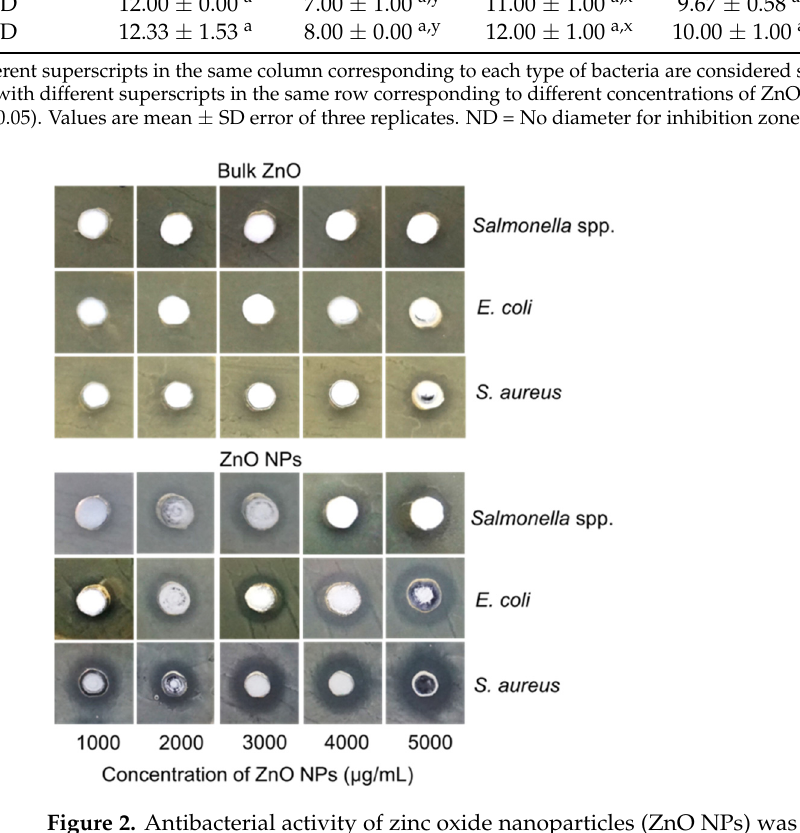
Figure 2. Antibacterial activity of zinc oxide nanoparticles (ZnO NPs) was investigated using the agar well diffusion method. Plates were incubated at 37 °C for 24 h, and images were taken at 24 h. Images are representative of three biological replicates.